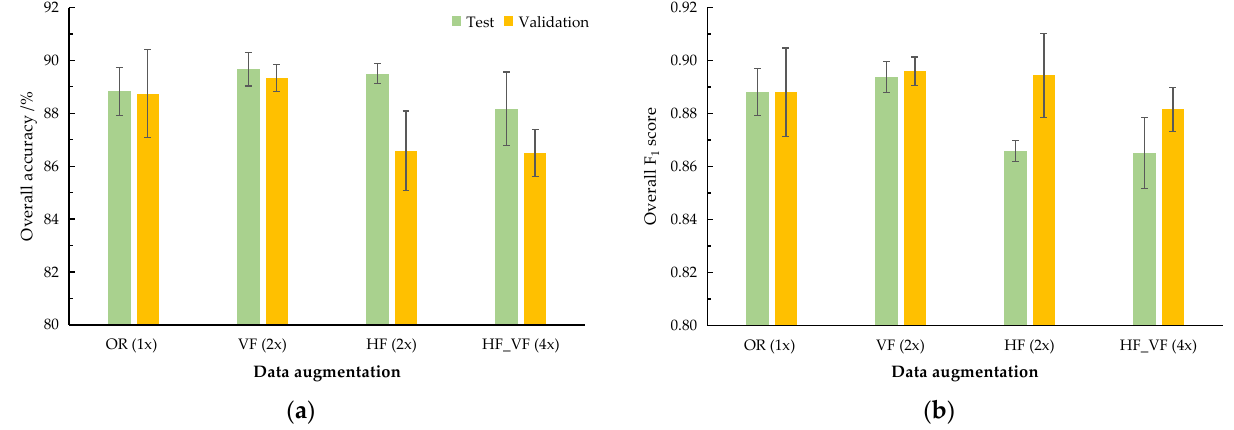
Figure 10. Assessment metric comparison of the validation and test results with data augmentation. ( a ) Overall accuracy; ( b ) Overall F 1 score. The division ratio of the JYU-GSM dataset is 0.8:0.1:0.1 for the training (400 images), testing (50 images), and validation (50 images) subsets. OR (1x) denotes the original training subset; VF (2x) denotes the OR (1x) and its vertical flip (2x); HF (2x) denotes the OR (1x) and its horizontal flip (2x); HF_VF (4x) denotes the OR (1x), its vertical flip, and their horizontal flip. All models are tested and validated on the same test and validation subsets, respec- tively. Table 12. Assessment metric comparison of the cross-validation results with image transformation and data augmentation.